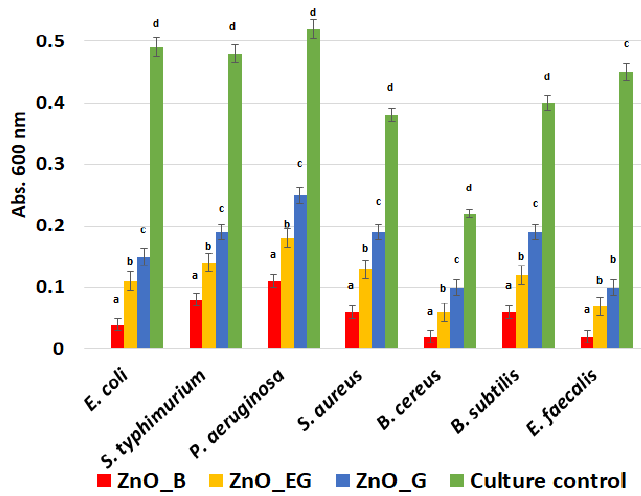
Figure 13. Graphic representation of average absorbance at 600 nm revealing growth of planktonic bacterial cultures in the presence of control and ZnO NPs for 24 h at 37 °C. Different small letters (a-d) indicate statistically significant differences between films ( p < 0.05).